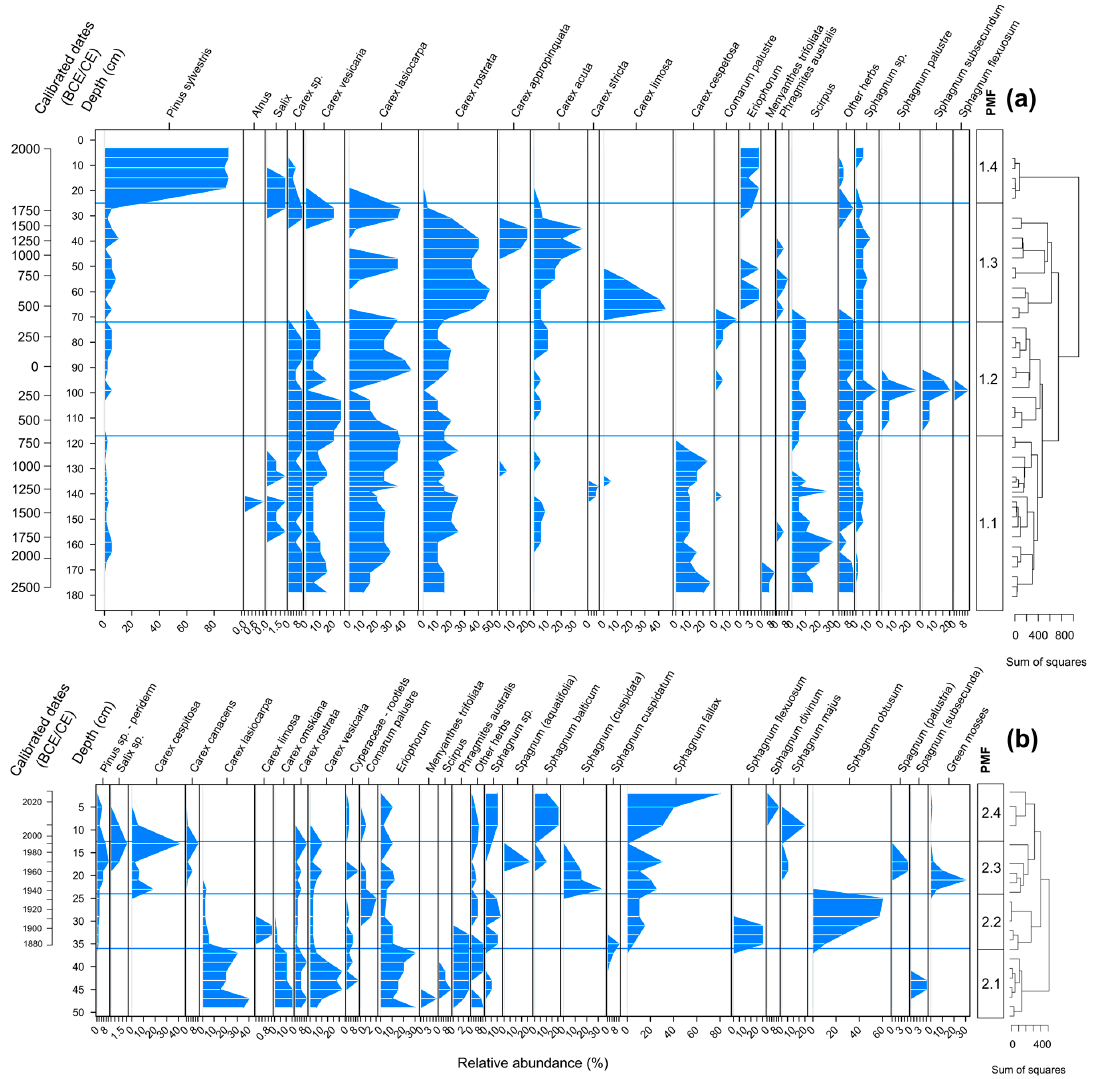
Figure 5. Plant macrofossil composition of the undisturbed ( a ) and fl oating mat ( b ) peat deposits in